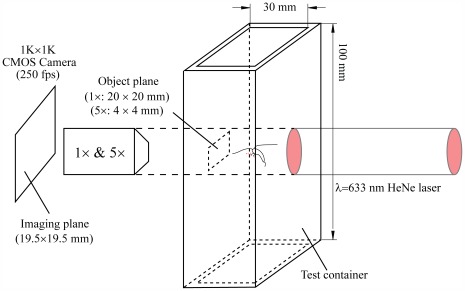
Experimental setup for in-line digital holographic cinematography.